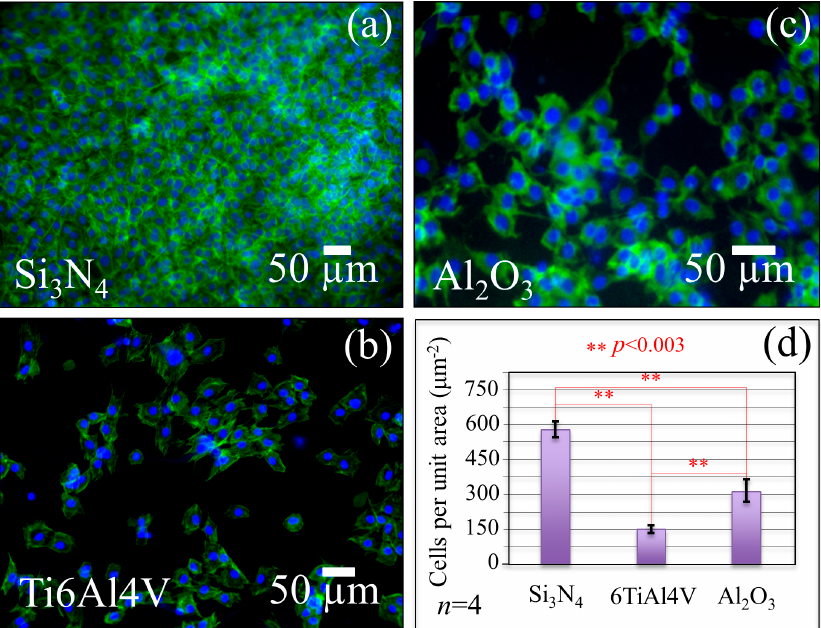
Figure 2. Fluorescence microscopy images of stained KUSA-A1 cells (nuclei and F-actin in blue and green, respectively) that proliferated for 24 h on ( a ) Si 3 N 4 , ( b ) Ti6Al4V alloy, and ( c ) Al 2 O 3 substrates; in (d) , quantitative plot and statistical validation of cell counting on different substrates. Statistics were made according to the one-way Analysis of Variance (ANOVA) to assess the plot in ( d ). Assessments of differentiation and osteogenic metabolism in mesenchymal KUSA-A1 cells exposed for nine days to different substrates are given in Figure 3a–c. In Figure 3a,b, comparative plots of γ -carboxyglutamic (Gla)- and undercarboxylated (Glu)-osteocalcin, respectively, are given for cell-line exposure to different substrates. Statistically significant differences in concentration can be noticed in the Gla-osteocalcin plot, with the Si 3 N 4 substrate reaching values more than one order of magnitude larger than and almost twice as those recorded for negative and positive control samples, i.e., cultured on silica glass without and with osteogenic medium, respectively, but otherwise under the same experimental conditions. The concentration of Gla-osteocalcin for mesenchymal cells exposed to the Si 3 N 4 substrate was about 56% and 89% higher than those measured for exposures of cells to Ti6Al4V alloy and Al 2 O 3 substrates, respectively. The Gla residue of osteocalcin is a specific and highly sensitive parameter for quantitative assessments of decarboxylated osteocalcin from the bony tissue produced by KUSA-A1 cells that differentiated into mature osteoblasts. Conversely, concentrations of the Glu residue, which is synthesized by osteoclasts, were the lowest in both Si 3 N 4 and Ti6Al4V alloy substrates; no statistically significant difference between the two values was found but both were lower by ~40% and 30% than both positive and negative control, respectively. Note that the Al 2 O 3 substrate experienced the lowest and the highest concentration of Gla- and Glu-osteocalcin supernatants, respectively, thus not only revealing the lowest propensity to osteoblastogenesis but also a conspicuous propensity for the mesenchymal cells to differentiate into mature osteoclasts.